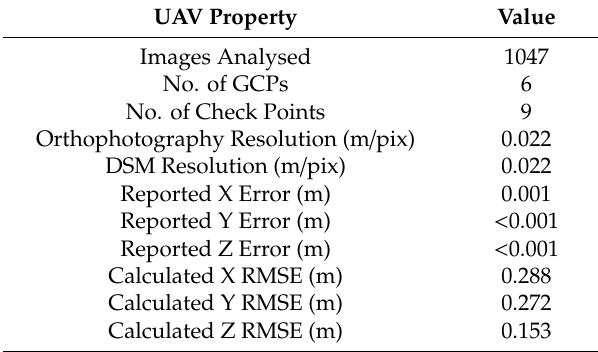
Table 1. Images analysed, number of ground control points (GCPs), number of check points, resolution of the orthophotography and digital surface models (DSMs), reported error and calculated root-mean-square error (RMSE) between the DSMs, and check points for the unmanned aerial vehicles (UAV)